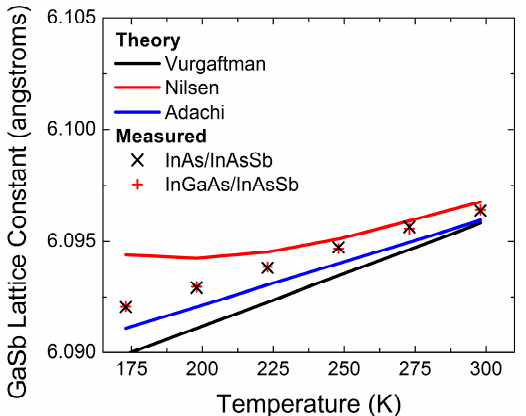
Figure 3. GaSb lattice constant based on models from the literature, as well as measured values from both samples (labeled by their superlattice).